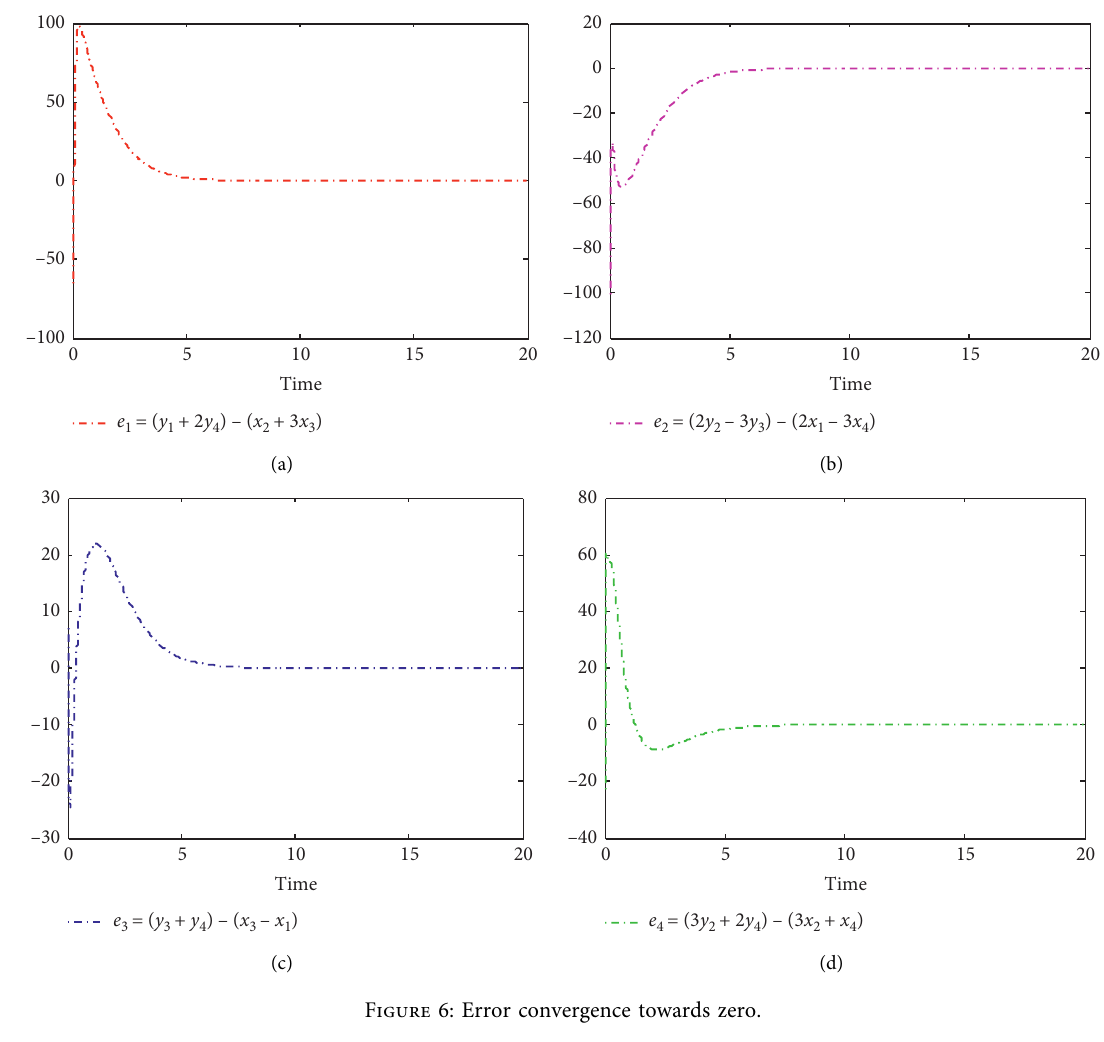
Figure 6: Error convergence towards